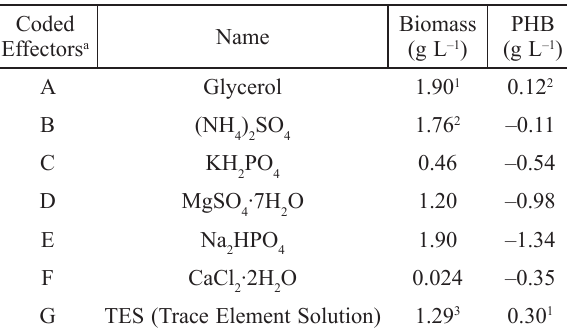
Table 3 – Statistical ‘t’-value coefficients for different